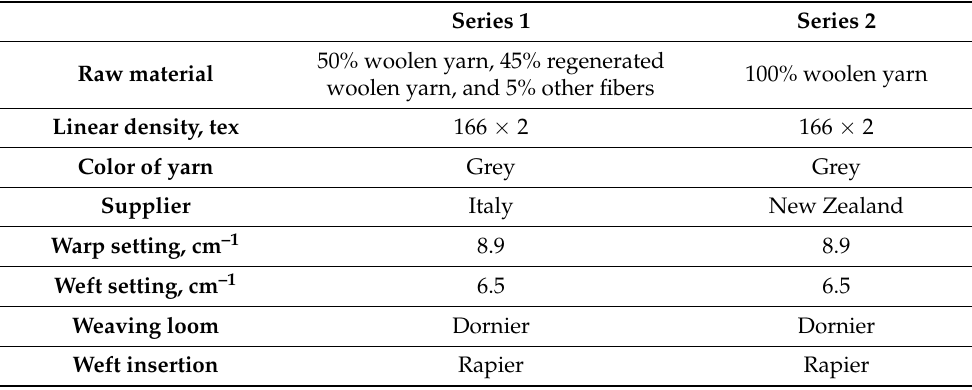
Table 1. Structural parameters of the